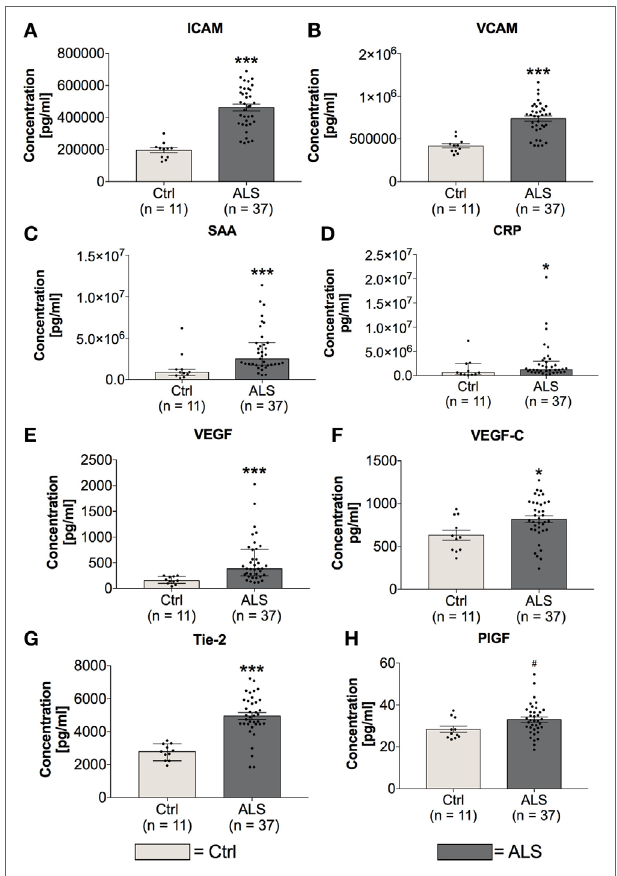
FigUre 3 | Serum concentrations of vascular and general inflammatory markers. Amyotrophic lateral sclerosis (ALS) patients showed a significantly enhanced expression profile of vascular and endothelial factors ICAM (a) and VCAM (b) , as well as general inflammatory markers SAA (c) and CRP (D) . Further, circulating levels of angiogenic factors including VEGF (e) , VEGF­C (F) , Tie­2 (g) , and PIGF (h) were increased in sera of ALS patients. * p < 0.05 vs. controls (Ctrl), *** p < 0.001 vs. Ctrl; # = trend, p = 0.0593. Numbers of patients are given in brackets. All parameters were tested for